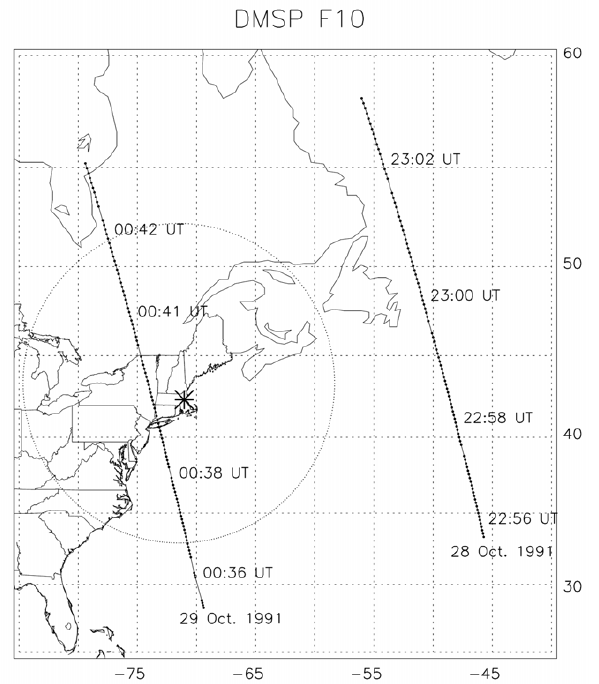
Fig. 9. Map showing the locations of two DMSP over-flights of the Figure 9. Map showing the locations of two DMSP over-flights of the Millstone Hill Millstone Hill area on the night of 28–29 October area on the night of 28-29 October 1991.